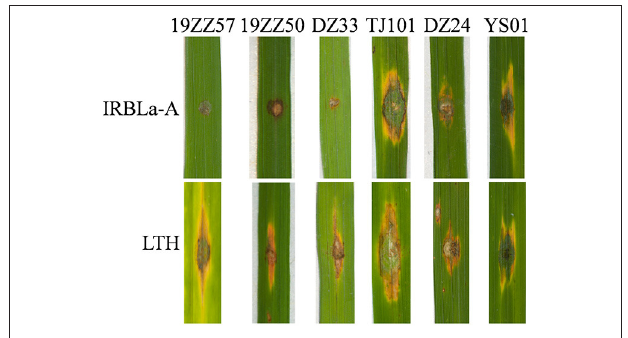
FIGURE 2 | Loss of AVR-Pia broke down the resistance of Pia in rice. The representative blast disease phenotypes displayed on the leaves of susceptible line Lijiangxin Tuan Heigu (LTH) upon inoculation with the indicated strains. IRBLa-A is the monogenic line harboring the blast resistance gene Pia . AVR-Pia is present in the three isolates, namely, 19ZZ57, 19ZZ50, and DZ33, but not in the others, TJ101, DZ24, and YS01. The representative figures were taken at 5 days postinoculation